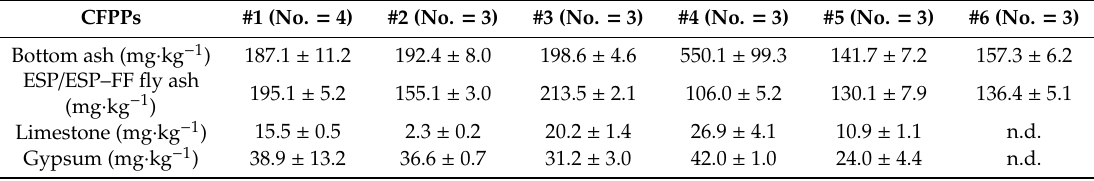
Table 3. Cr concentration in bottom ash, ESP / ESP–FF fly ash, limestone, and gypsum.